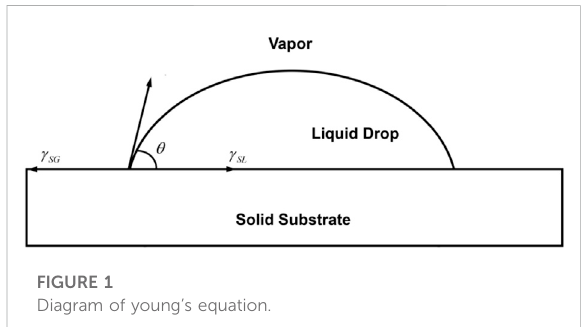
FIGURE 1 Diagram of young ’ s